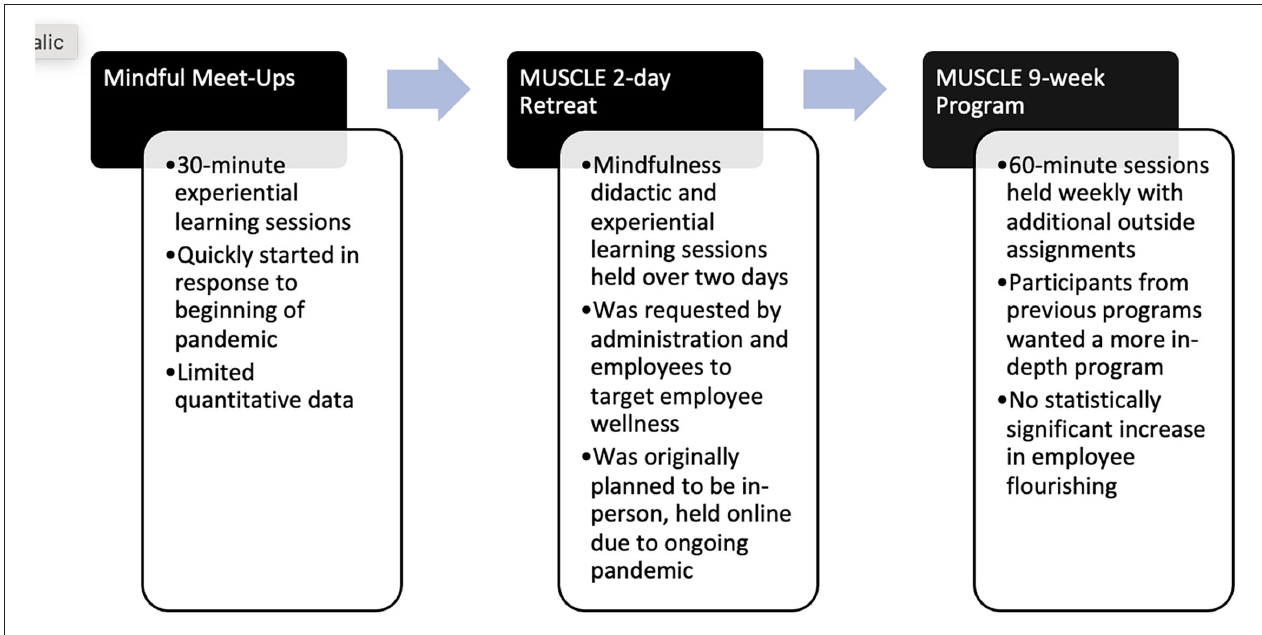
FIGURE 1 | Chronological development of mindfulness